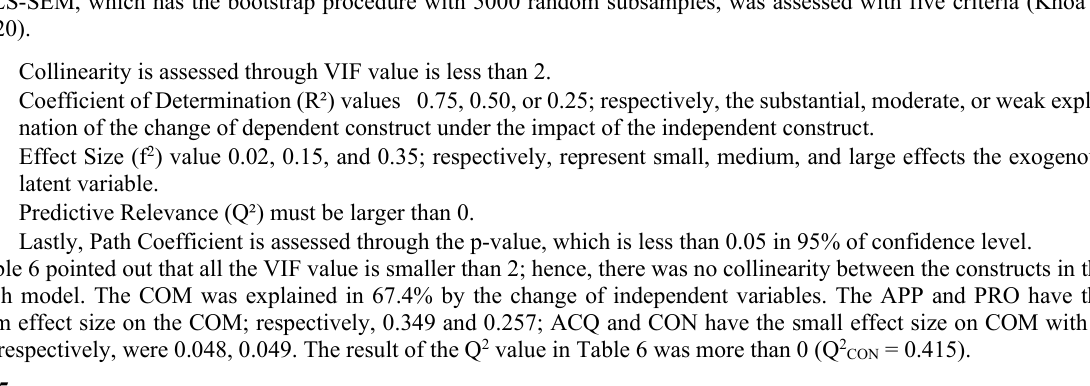
The result of VIF, R 2 , f 2 , and Q 2